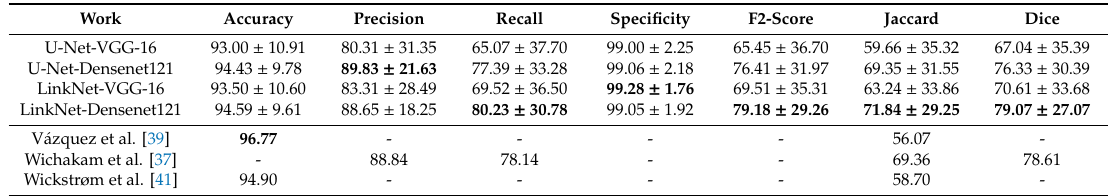
Table 7. Comparison of the eigenloss of the four models with other works that also use CVC-EndoSceneStill as the dataset. Best values are indicated in